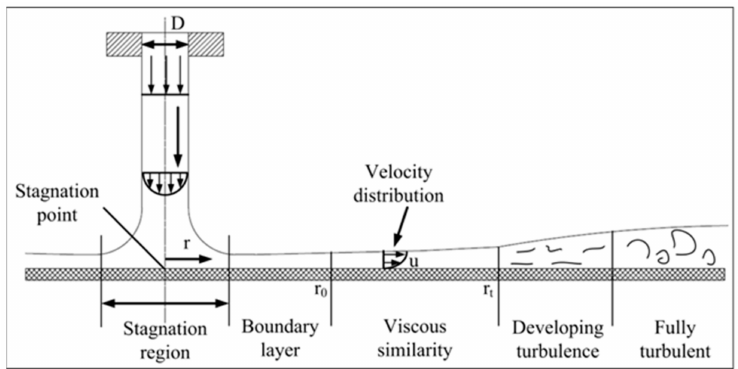
Figure 4. Schematic diagram of jet flow field of circular nozzle